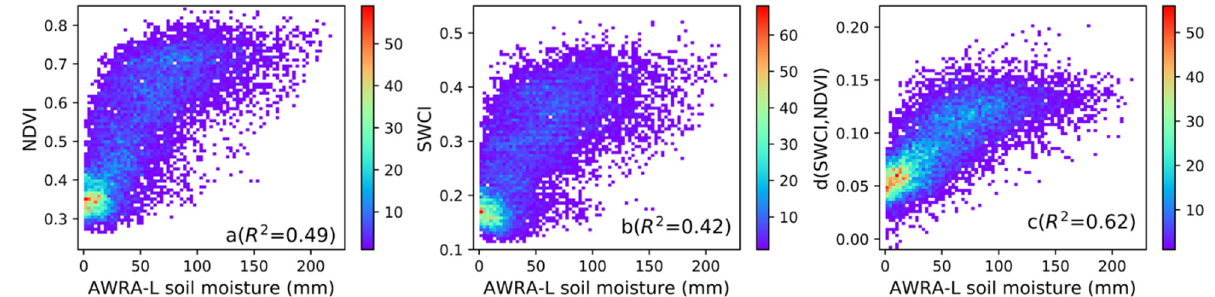
Figure 7. Density scatter plot with R 2 values of weekly observations from sixty study sampling windows: ( a ) NDVI vs. AWRA-L soil moisture, ( b ) SWCI vs. AWRA-L soil moisture, ( c ) d(SWCI, NDVI) vs. AWRA-L soil moisture. The color shows the number of observations per pixel.